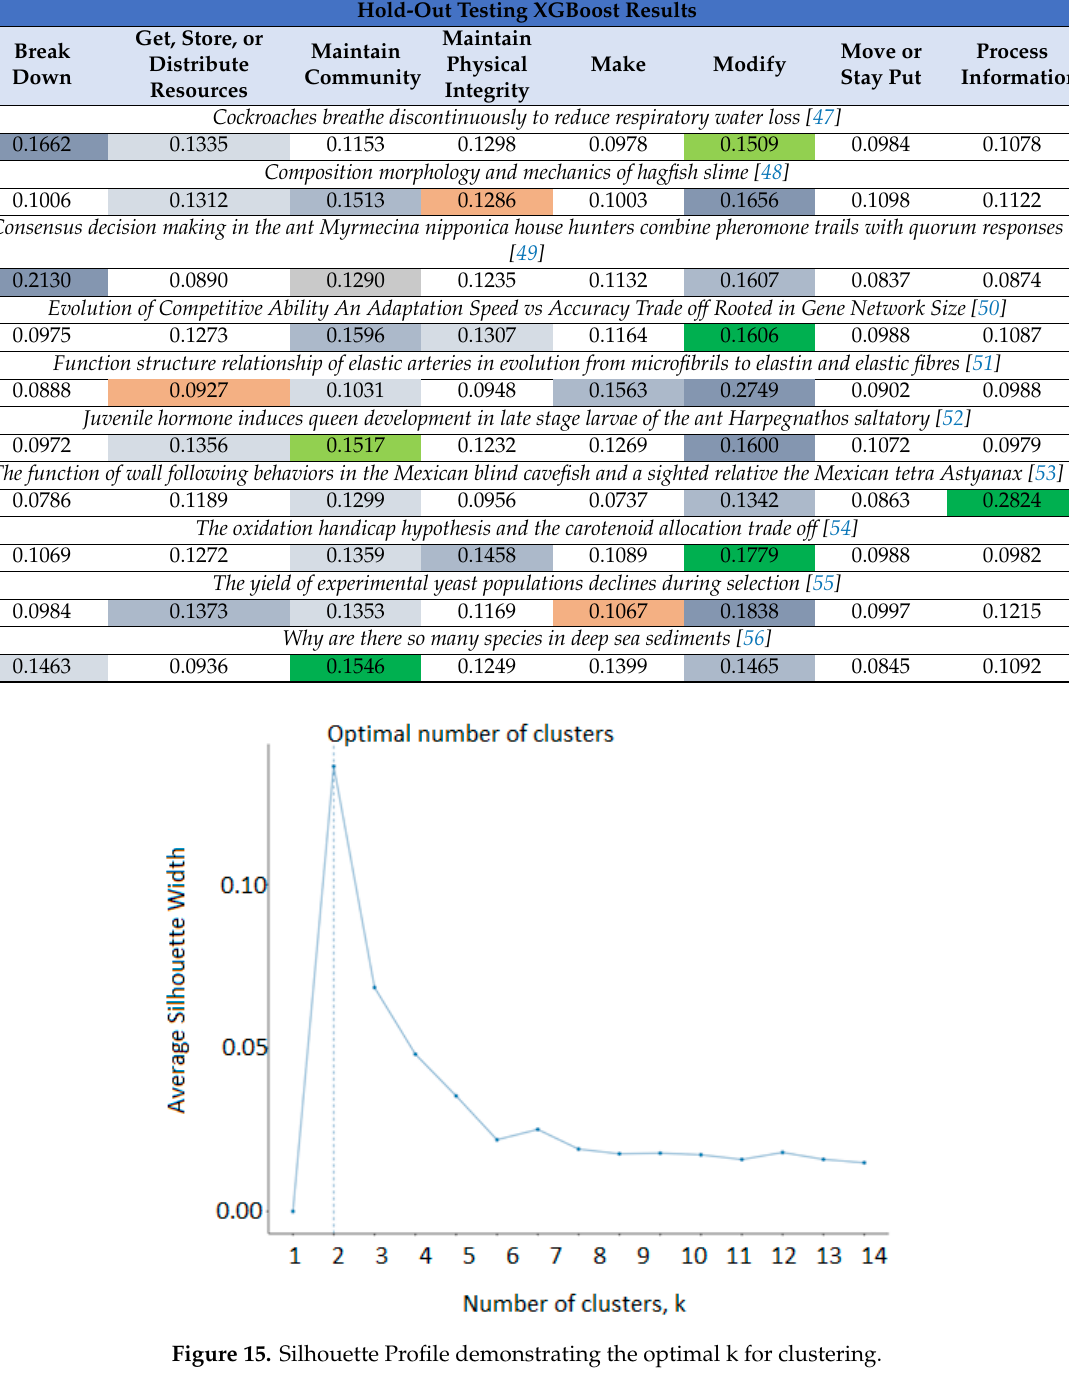
Table 3. Classification probability scores for hold-out testing data set.